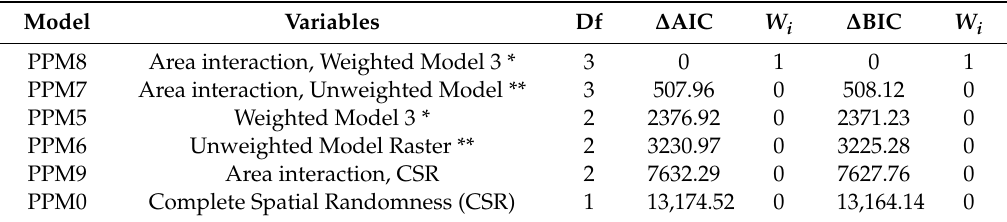
Table 6. Results of comparing 6 PPMs using Δ AIC, Δ BIC and their associated weights. Four PPMs (5, 6, 7 and 8) are comprised of predictive rasters created in ArcGIS. The other 2 (PPM0 and PPM9) represent CSR and area interaction processes without environmental covariates. The weighted model with area interaction (a second-order property) performs better than all other models. Df = degrees of freedom; W i = information criterion weight value.